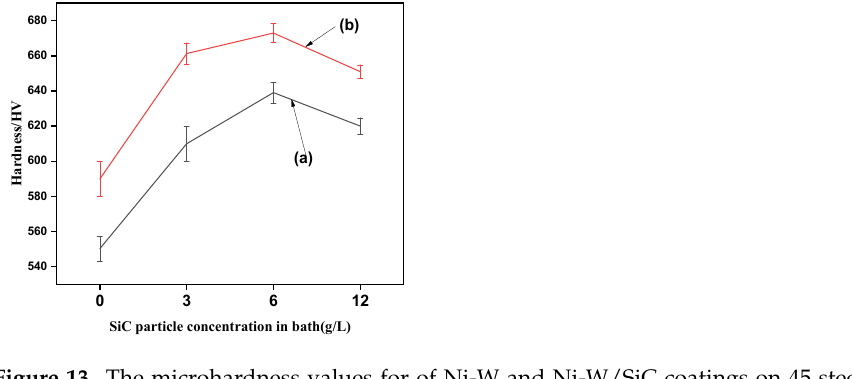
Figure 13. The microhardness values for of Ni-W and Ni-W/SiC coatings on 45 steel substrates sub- jected to ( a ) polishing and ( b ) grit-blasting pretreatments by varying the SiC concentration in the